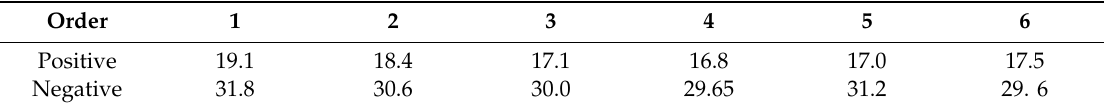
Table 2. Values of standard deviation for different order polynomial fits.